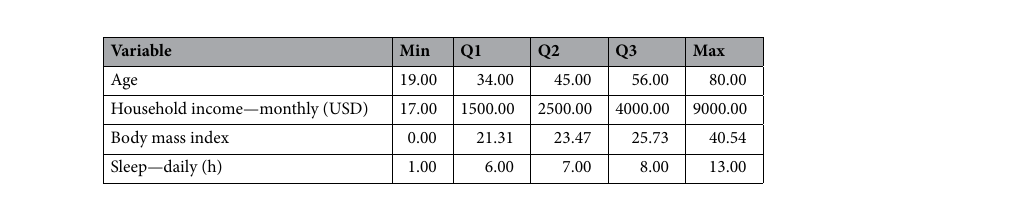
Table 2. Descriptive statistics: continuous